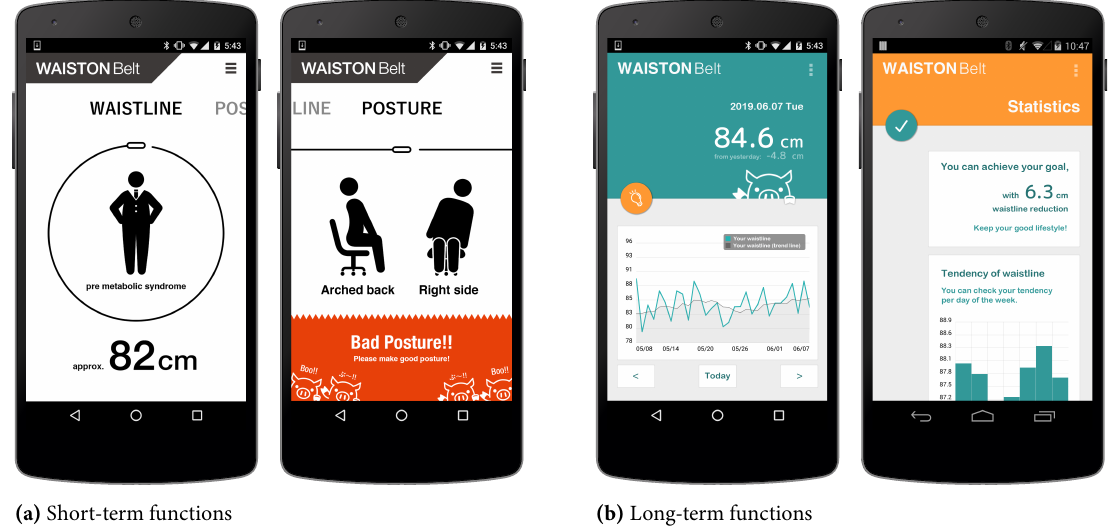
Figure 9. Smartphone application for short- and long-term intervention and